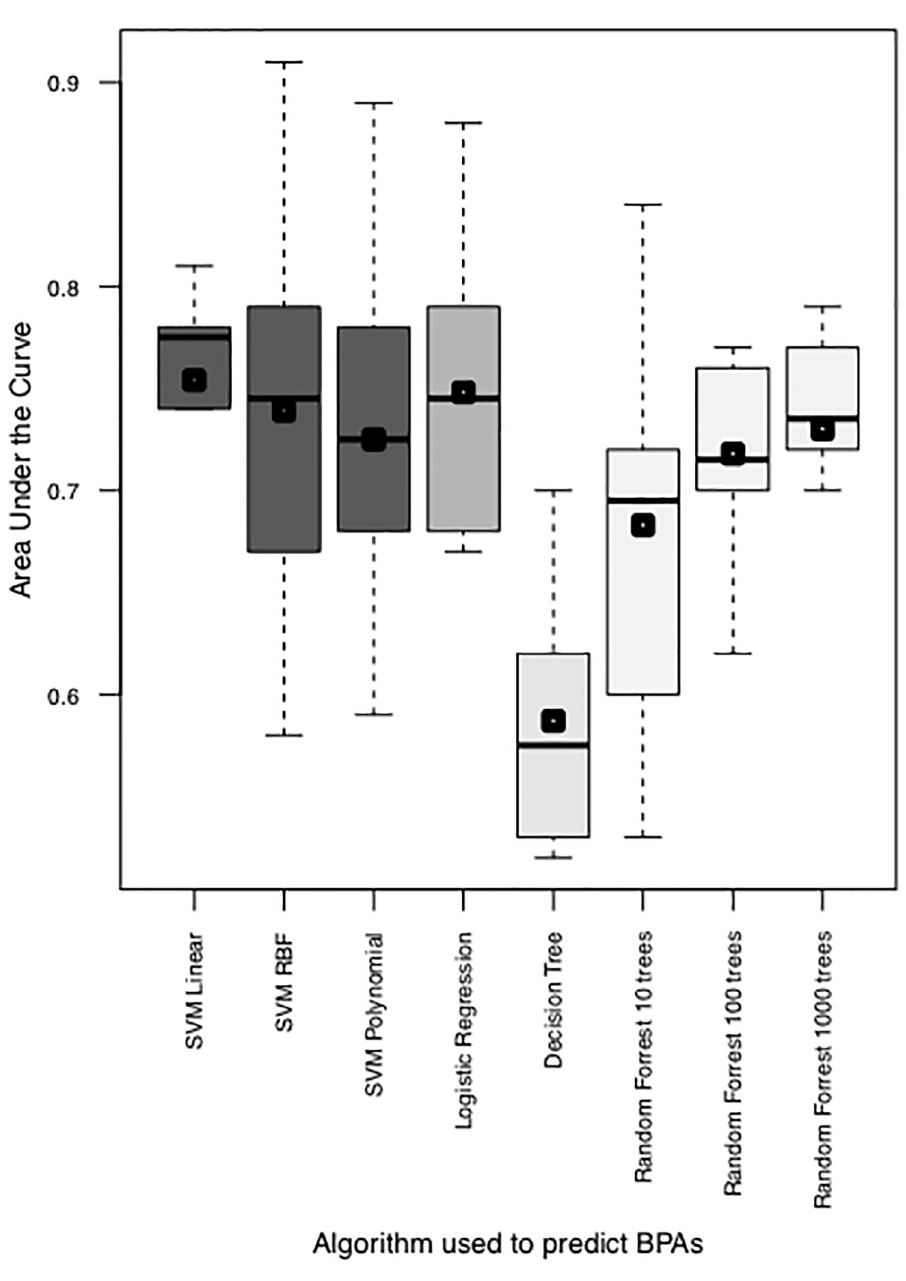
Fig 2. Comparison of area under the curve (AUCs) obtained in leave tenth out cross validation (LTOCV) of different machine learning algorithms predicting bacterial protective antigens (BPA) or non-BPAs from the curated dataset of BPAD200. All classifiers were built using the previously determined top 10 features for BPA prediction in reverse vaccinology for support vector machine (SVM) classification [16]. The mean of the LTOCV tenths were plotted as a square on the